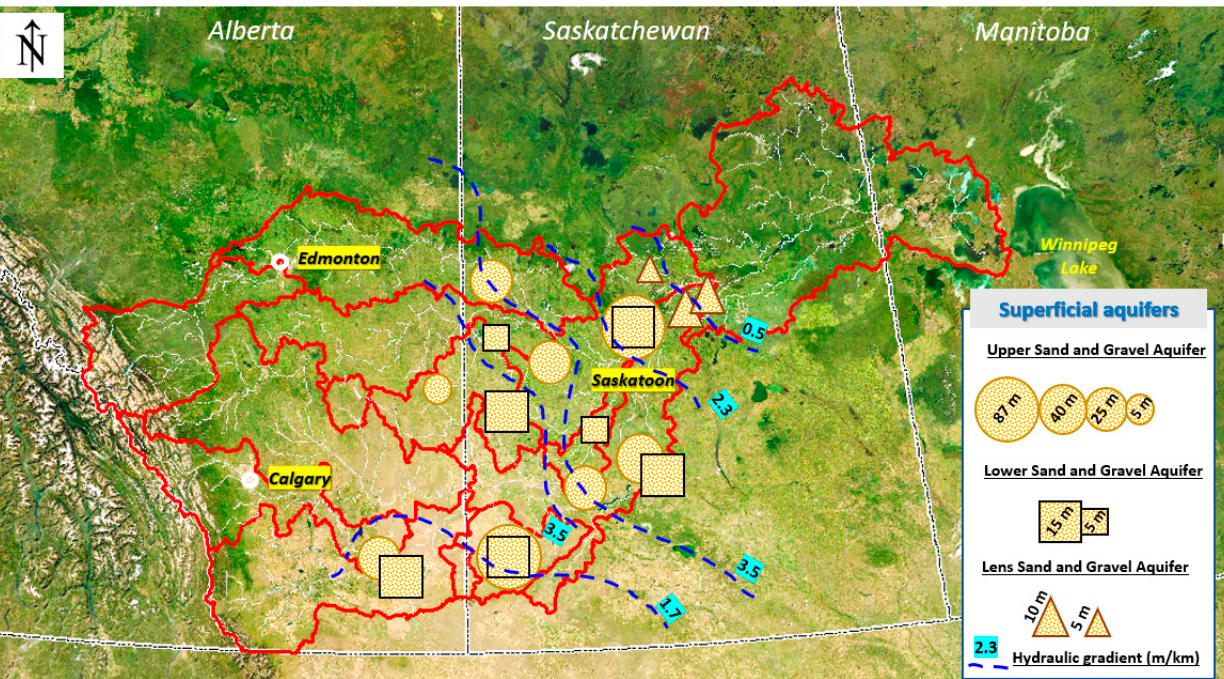
Figure 9. Proposed 3D geological model of the Saskatchewan River Basin.